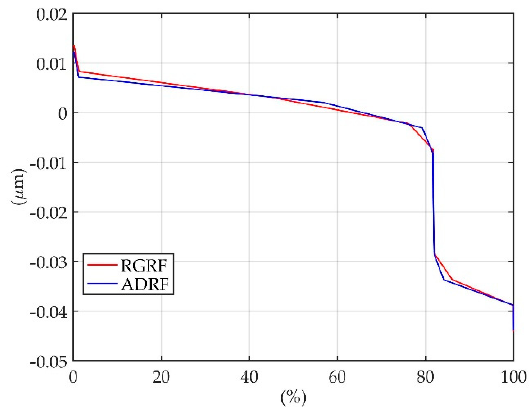
Figure 17. Material ratio curves after using the ADRF and RGRF filter.